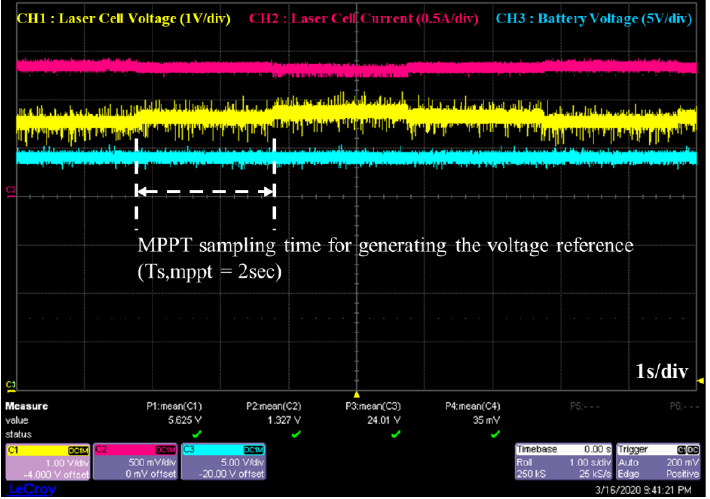
Figure 21. Enlarged waveform of MPPT control operation.